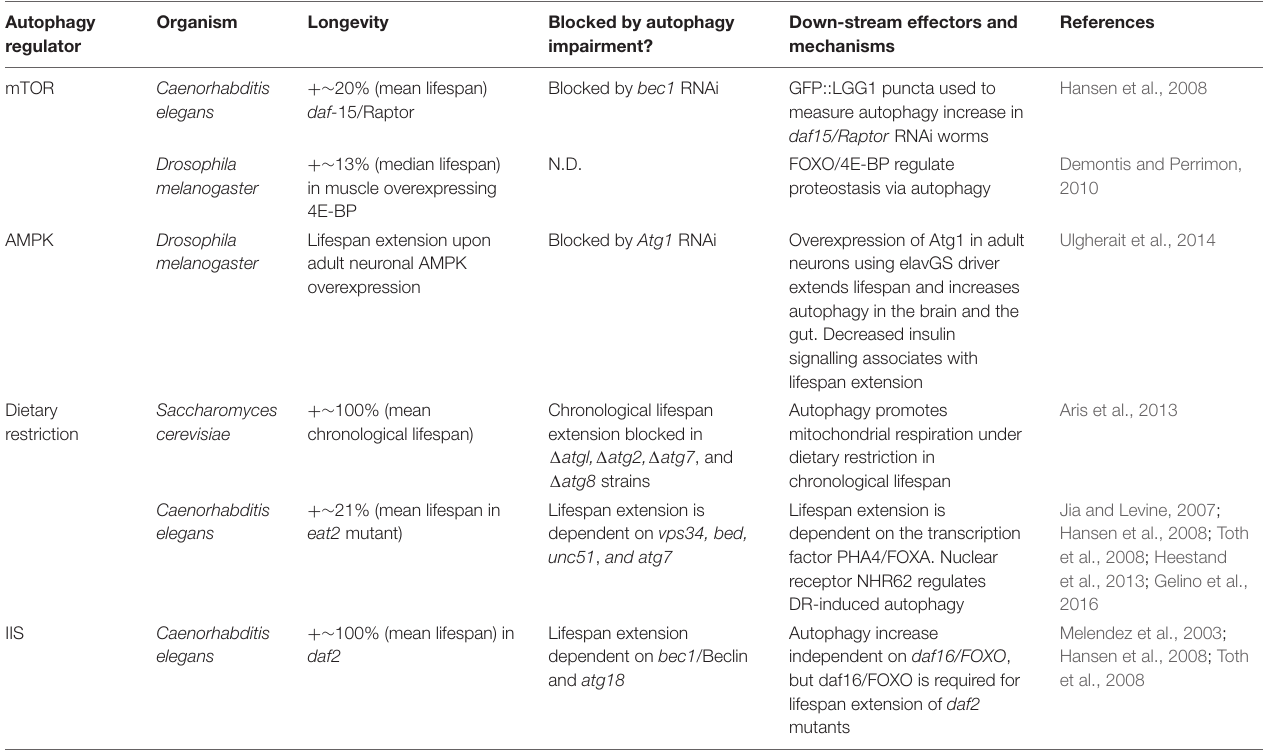
TABLE 1 | Autophagy regulators and down-stream